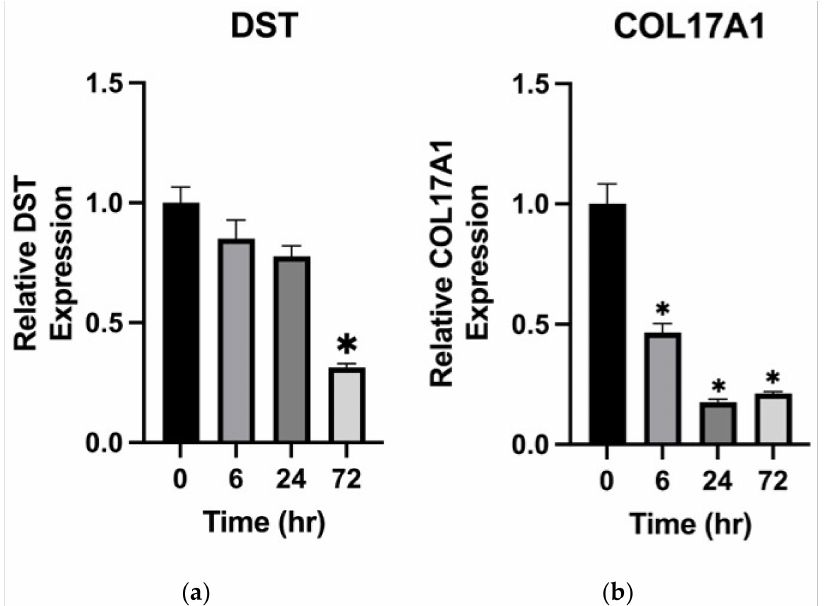
Figure 3. Vildagliptin decreased the expression of DYS and Collagen 17A1 in a time-dependent manner. HaCaT was treated with Vildagliptin (5 µ M) for 0, 6, 24, and 72 h. The expression of ( a ) DYS and ( b ) Collagen 17A1 was checked by qPCR. * [ p < 0.05].